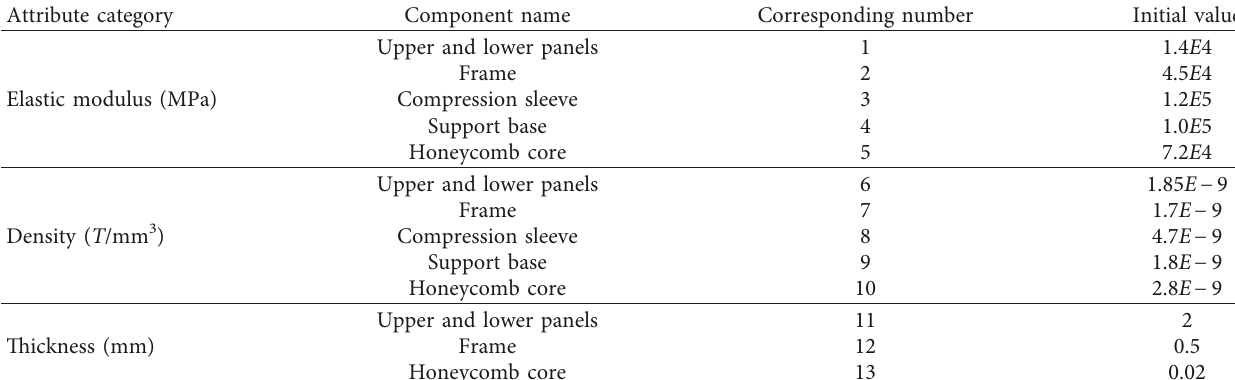
Table 3: Initial values of the elastic parameters and dimensions of the model.